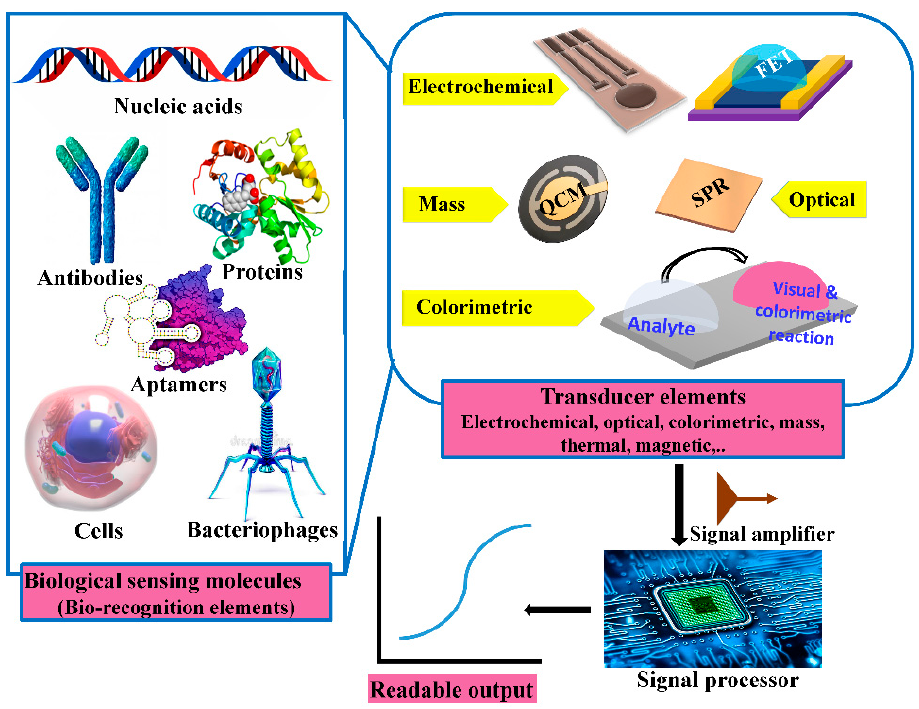
Figure 6. Main components of electrochemical biosensors; this figure is modified from [31].